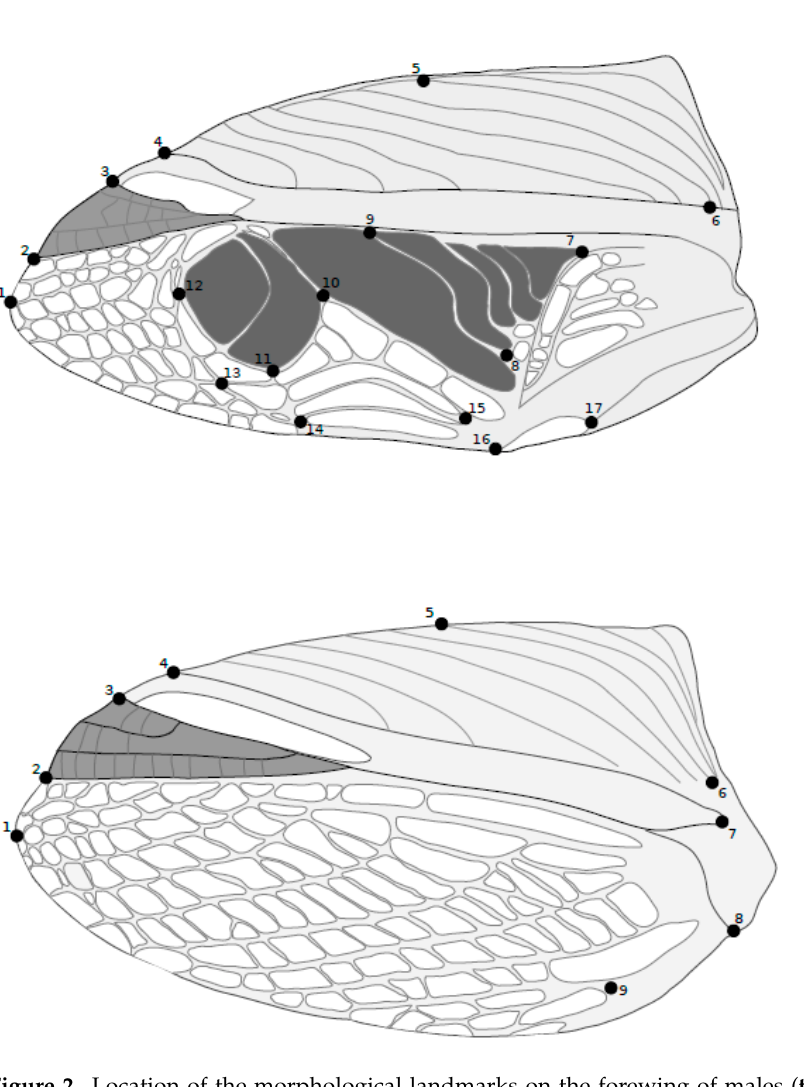
Figure 2. Location of the morphological landmarks on the forewing of males (top) and females (bottom). Forewings of the longwing and shortwing morphs were analyzed for each sex using geometric morphometric analyses.